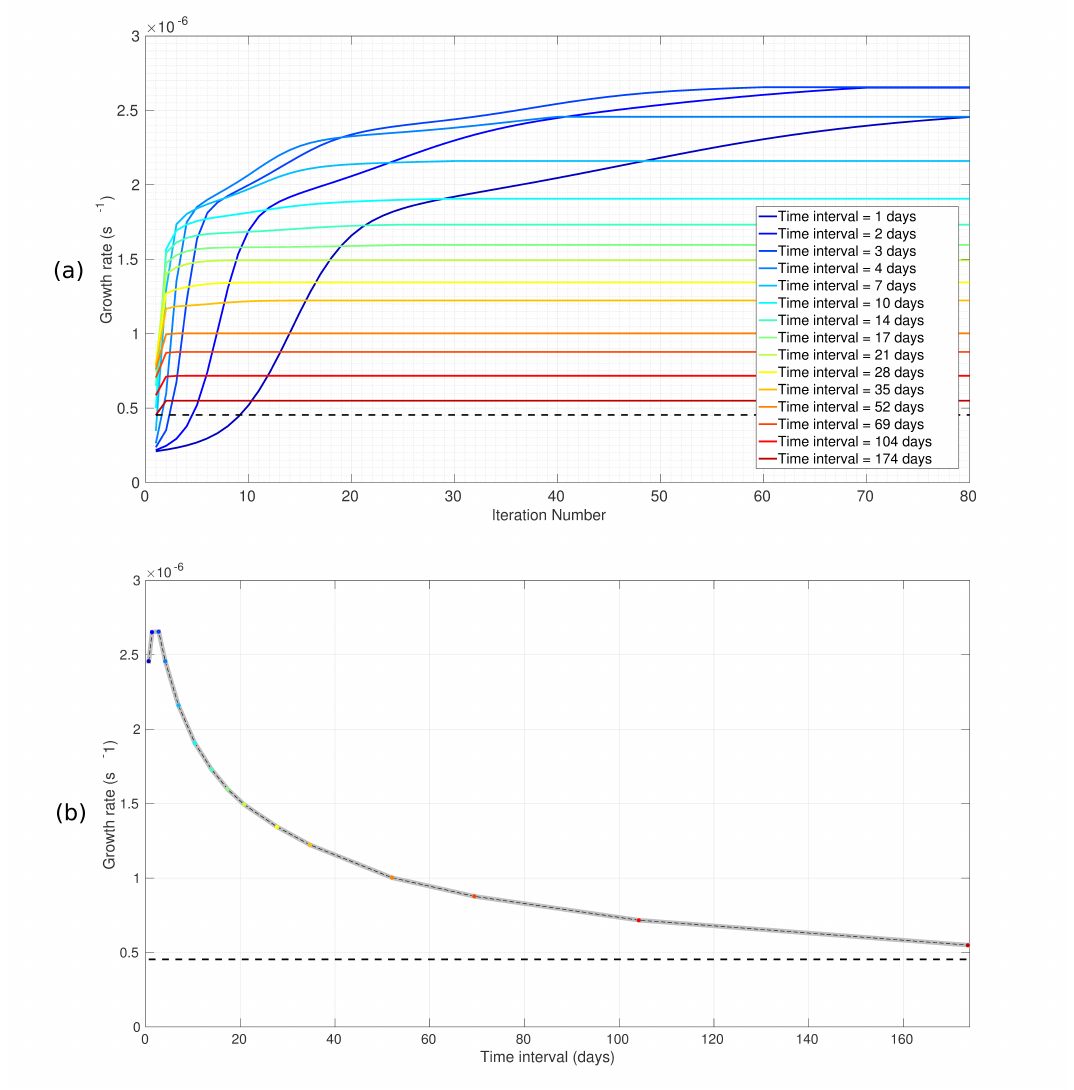
Figure 1. ( a ) Growth rate of the perturbation ( σ = log ( λ ) ) against the number of iteration through the 2 τ tangent linear and adjoint models for different time intervals τ . The additional discontinuous black line represents the growth rate of the most unstable normal mode ( m = 2). ( b ) Growth rate of the optimal perturbation against time interval after convergence of the solution (80 iterations through the tangent linear and adjoint models). The discontinuous black line represents the growth rate of the most unstable normal mode ( m =